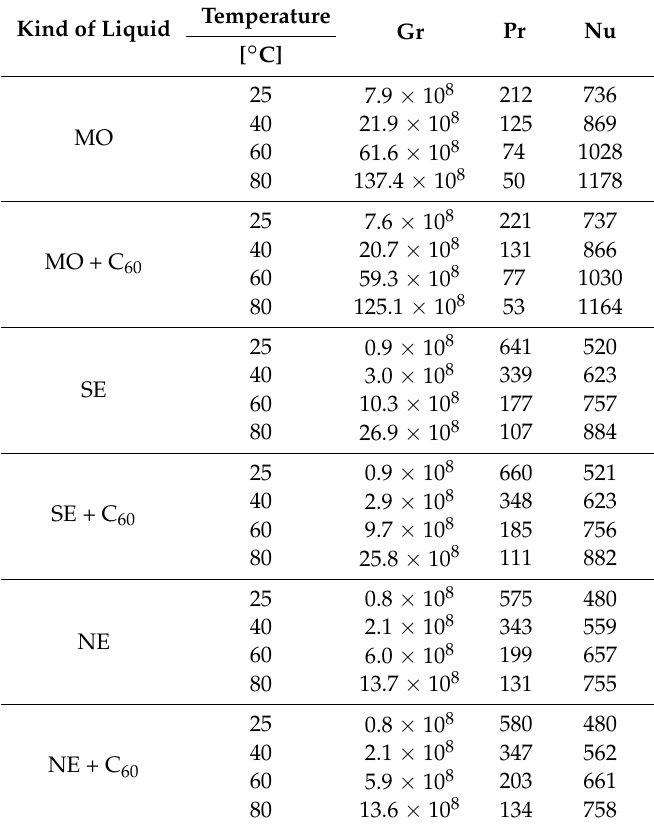
Table 4. Calculation results of the Grashof, Prandtl, and Nusselt numbers of pure electro-insulating liquids and nanofluids based on fullerene C 60